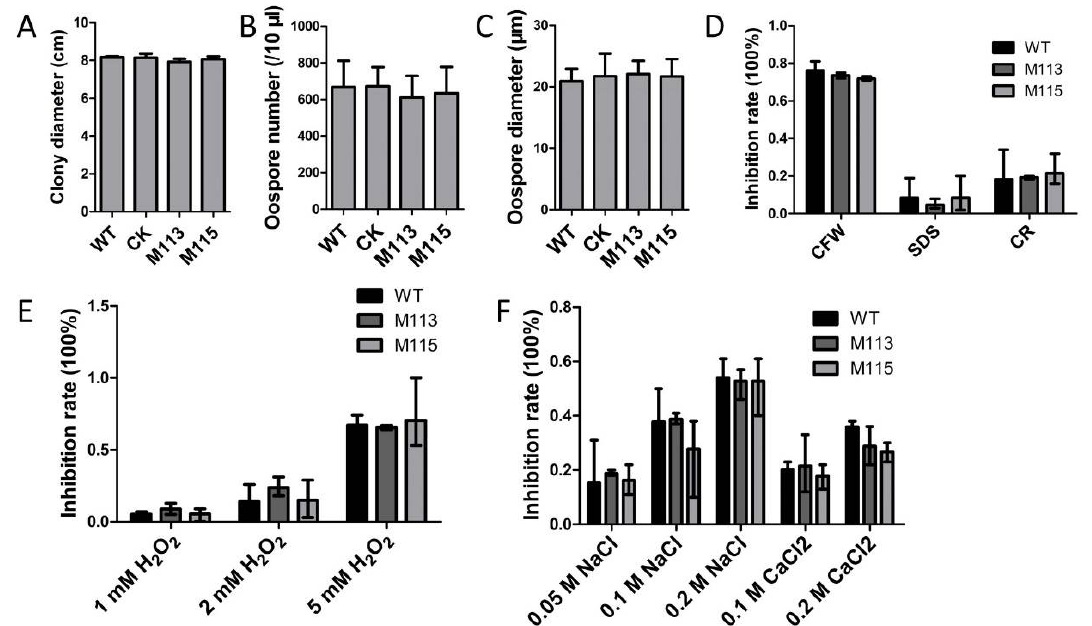
Figure 8. Assessment of mycelia growth, sexual reproduction and responses to various stresses. ( A ) Colony diameters of WT (wild type) or the PlMAPK2 mutants were measured 5 days after inoculation on CJA medium. ( B ) Oospore number at 10 days after inoculation on CJA medium. ( C ) Oospores diameters of WT and PlMAPK2 mutants at 10 days after inoculation on CJA medium. ( D ) Inhibition rates of WT and PlMAPK2 mutants on Plich medium supplemented with 350 µ g/mL CFW, 25 µ g/mL SDS or 100 µ g/mL CR. ( E ) Inhibition rates of WT and PlMAPK2 mutants on Plich medium with 1, 2 and 5 mM H 2 O 2 . ( F ) Inhibition rates of WT and PlMAPK2 mutants on Plich medium with 0.05 mM NaCl, 0.1 mM NaCl, 0.2 mM NaCl, 0.1 mM CaCl 2 and 0.2 mM CaCl 2 . CK: the transformant failed to acquire PIMAPK2 mutation. These experiments were repeated three times, with three replicas each time.